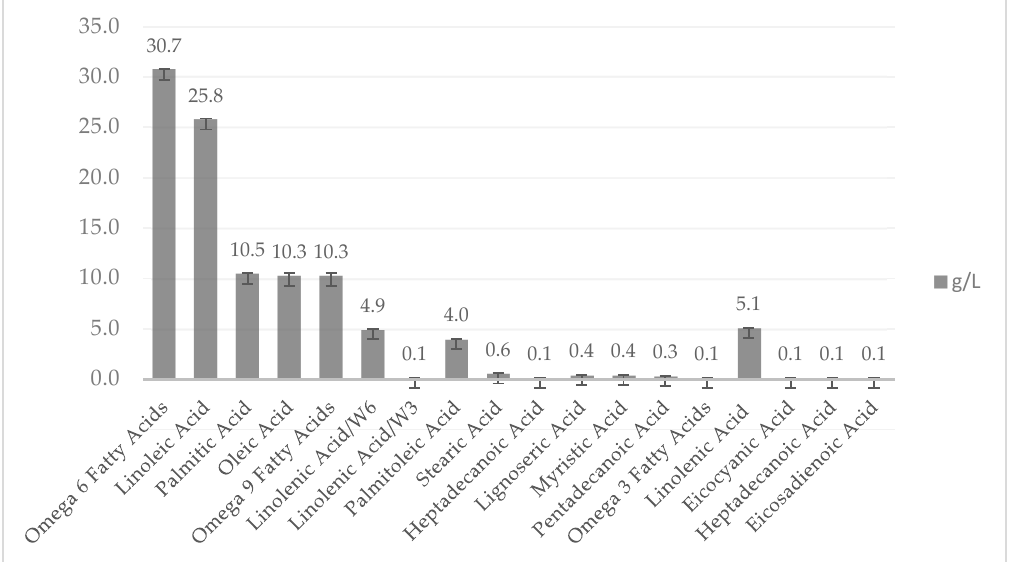
Figure 5. Fatty acid composition of fungal biomass cultivated on residual water from the first boiling of tempeh processing with the addition of yeast extract and incubated at a pH of 4.5 and aeration of 125 rpm.